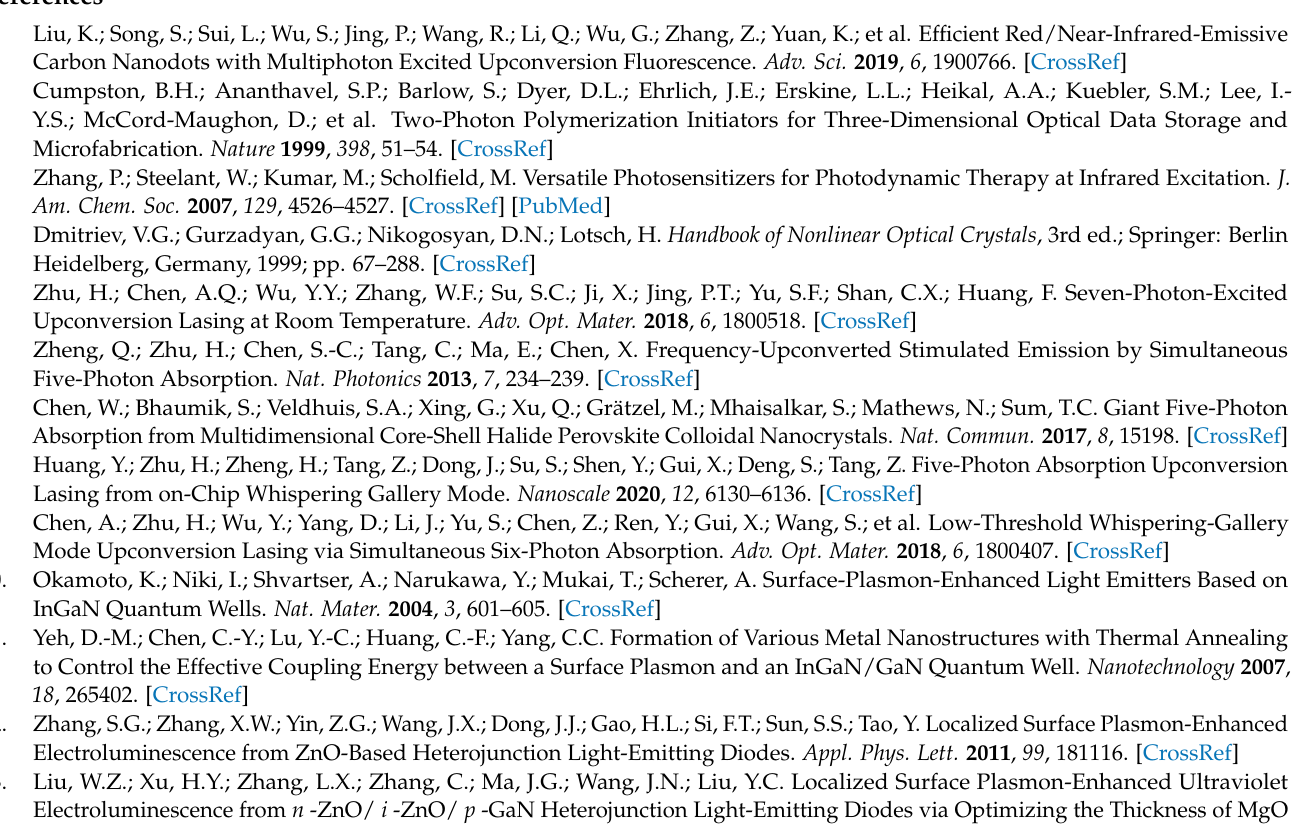
Figure S3: The variation diagram of the third harmonic peak with power density; Figure S4: The histogram of size distribution of Au